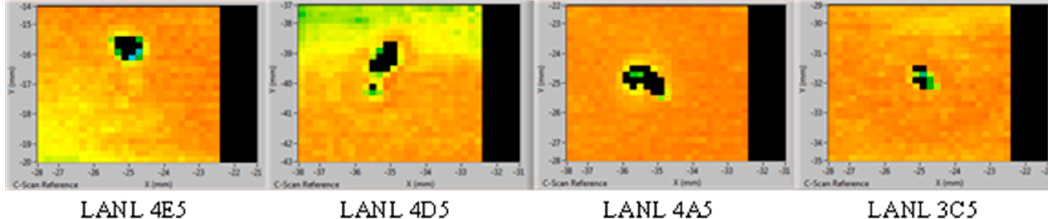
Figure 9. Representative images of the colorized debond locations in LANL plates caused by laser shock testing are shown. Note: The images are not to scale.